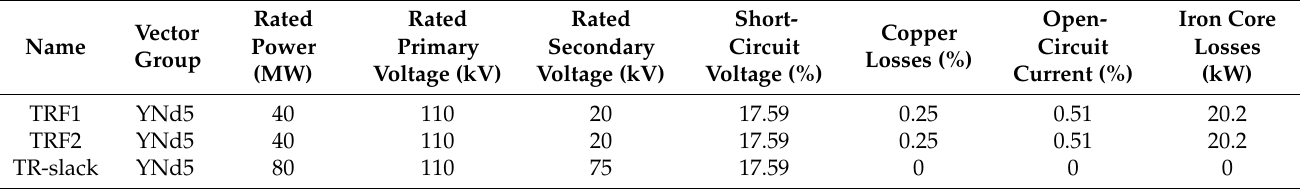
Table 9. Transformer